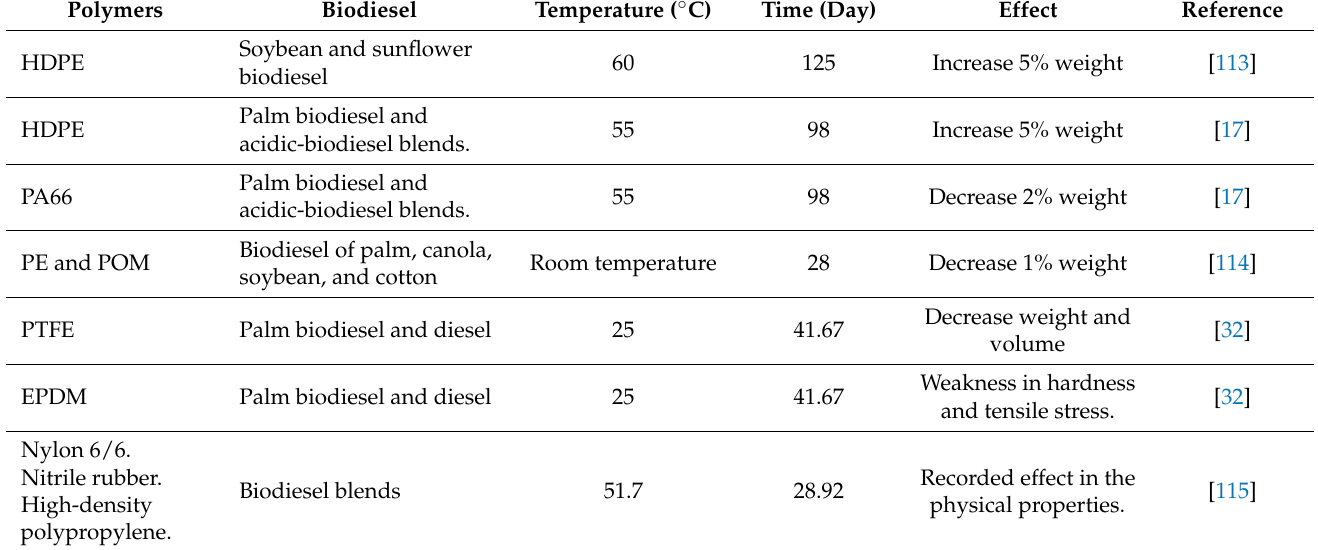
Table 9. Instable polymers toward biodiesel exposure.